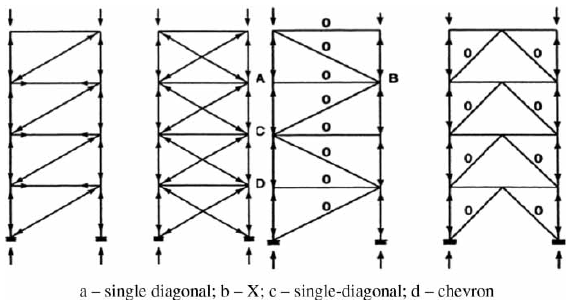
Fig. 9. Resulting forces in LSB systems due to gravity loads (Stafford Smith, Coull 1991) Fig. 7. Gravity load path in CBF systems (Taranath